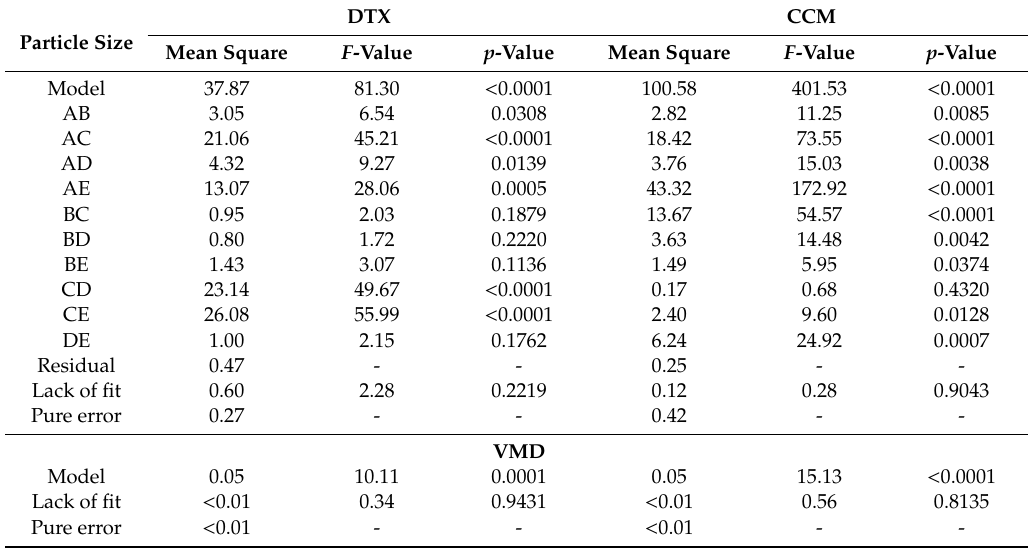
Table 2. Analysis of variance of the fitted quadratic model for particle size and the linear model for aerosol size (VMD) of the DTX- and CCM-loaded